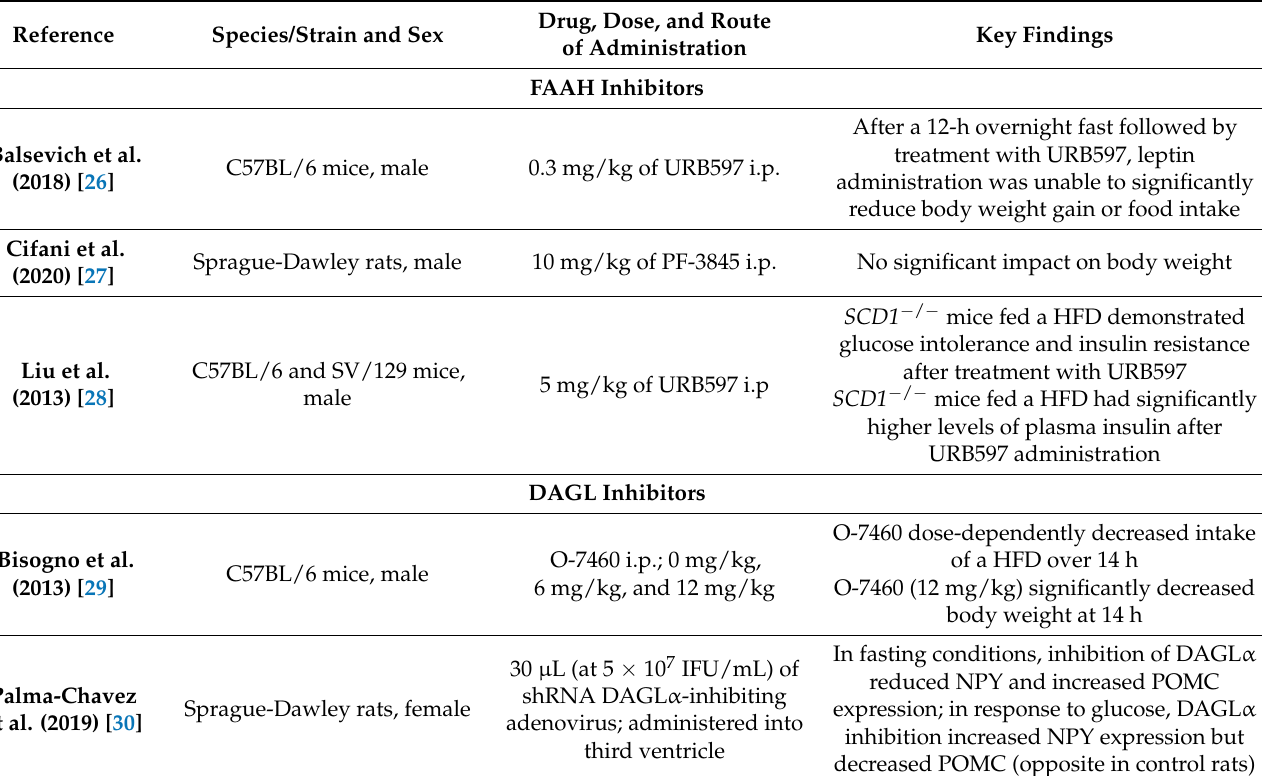
Table 1. Studies in animal models evaluating the impact of pharmacological manipulation of FAAH or DAGL enzymes on obesity-related